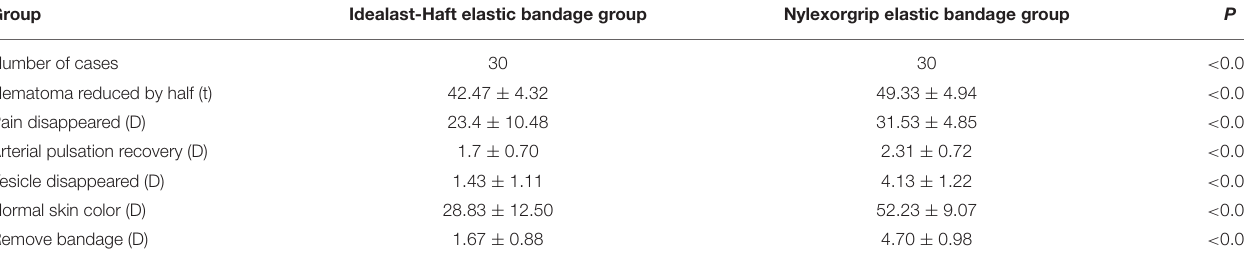
TABLE 5 | Improvements in the forearm